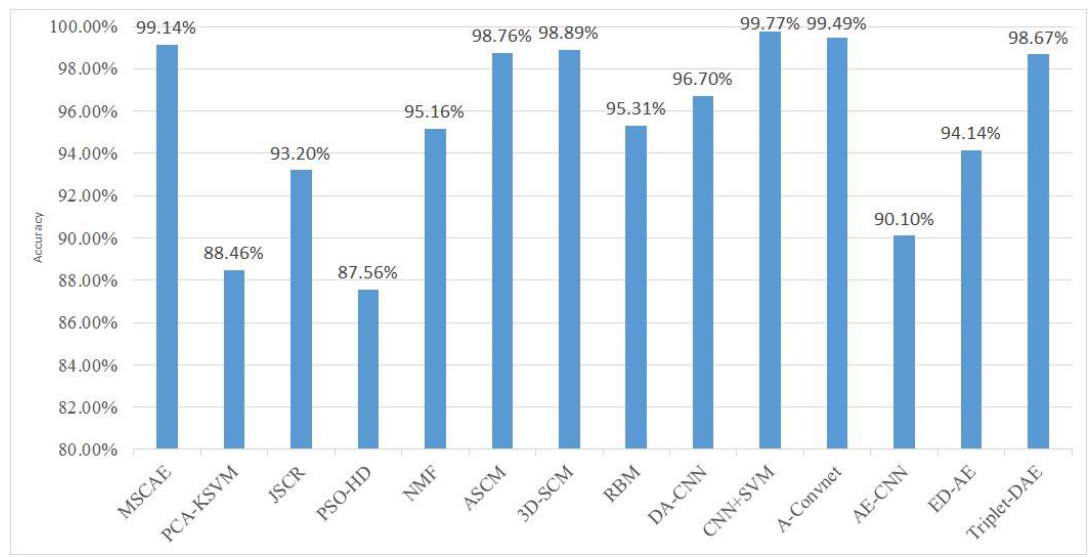
Figure 10. Performance comparison with baseline handcrafted feature extraction methods and deep representation models via the three-target dataset.